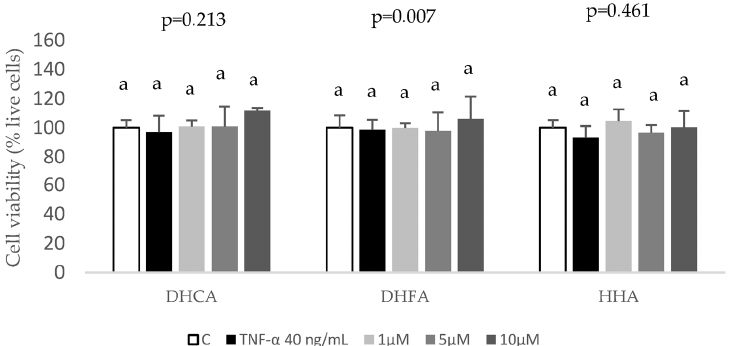
Figure 4. Effect of coffee microbial metabolites dihydrocaffeic acid (DHCA), dihydroferulic acid (DHFA), and hydroxyhippuric acid (HHA) at 0 (control, C), 1, 5 and 10 µM with cotreatment of TNF- α at 40 ng/mL during 6 h on cell viability in HepG2 cultures. Results, expressed as % of live cells, are means ± SD (n = 4). Within the same compound, there were no significant differences according to the ANOVA and the Bonferroni test ( p < 0.05).